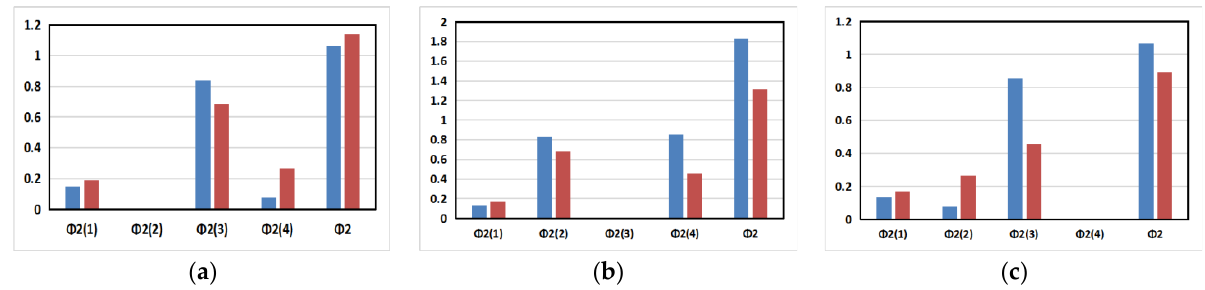
Figure 7. The differences of the waste gas emission volumes of the three tour routes in each subsection and the entire tour route between 360A and PRA, and between BDA and PRA. Blue column is the difference between 360A and PRA, red column is the difference between BDA and PRA. ( a – c ) are the comparison results for water tour route 1, route 2, and route 3, respectively.